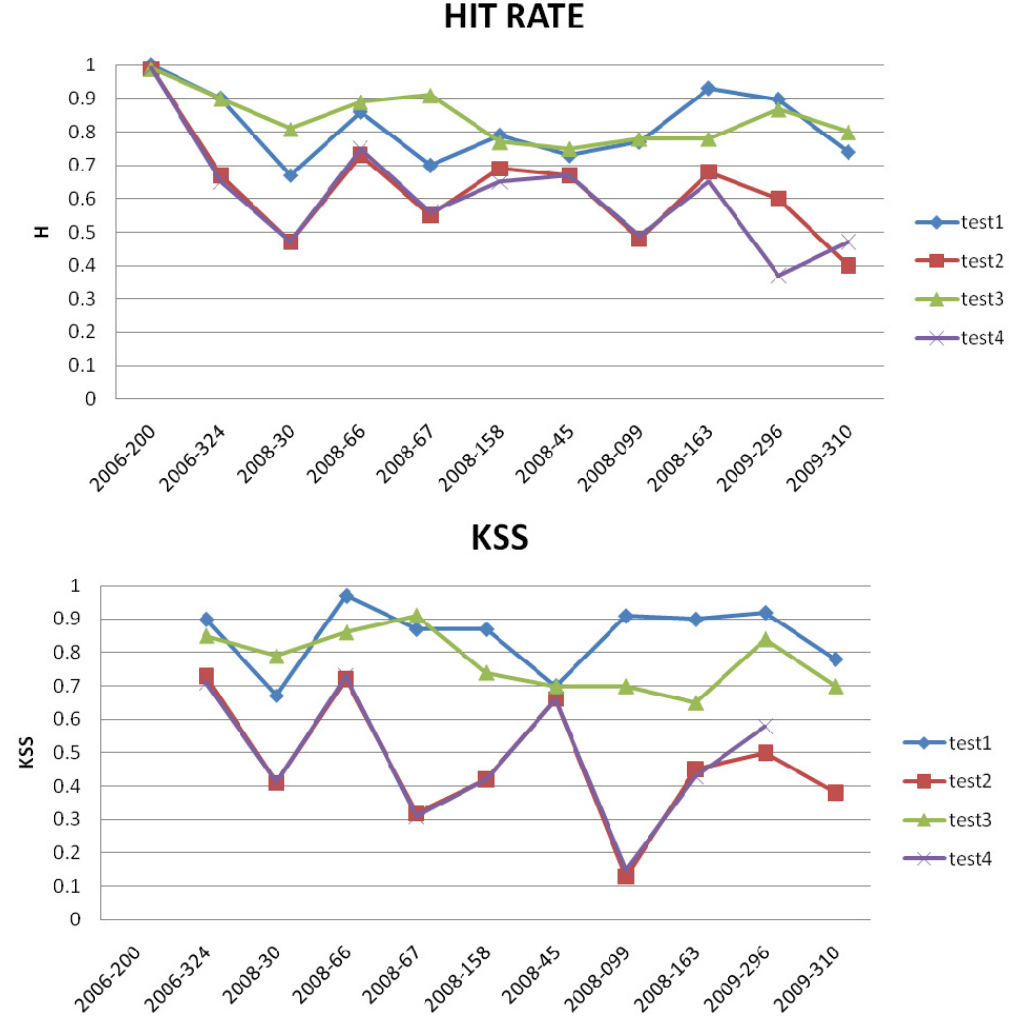
Figure 6. Hit rates (H) and Hanssen-Kuiper Skill Score (KSS) values for the different dates and